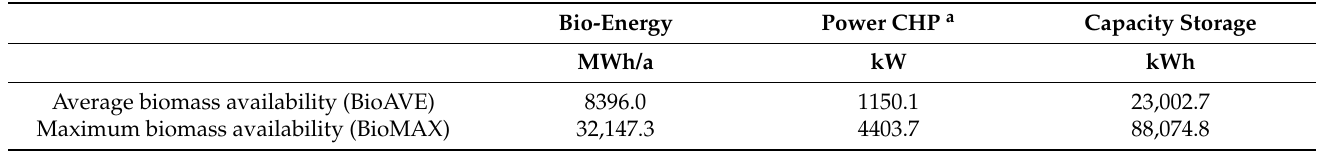
Table 8. Local biomass availability scenarios and resulting CHP power and storage capacity.